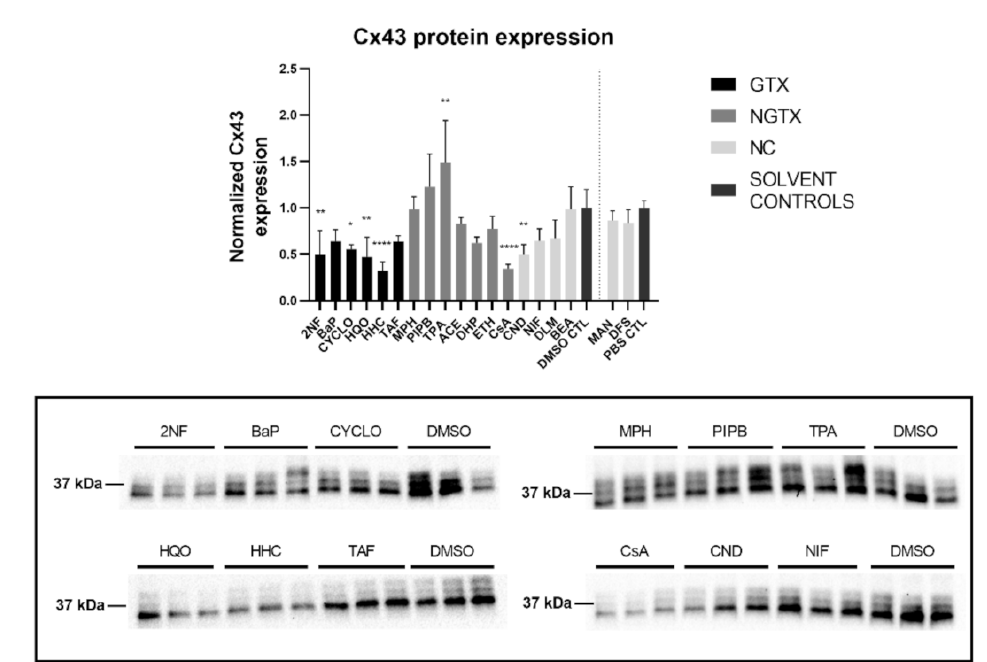
Figure 7. Cx43 protein expression in human hepatoma HepaRG cells exposed to GTX, NGTX and NC chemicals. Human hepatoma HepaRG cells ( n = 3 and N = 1) were exposed to GTX, NGTX, and NC chemicals for 72 h. Densiometric quantitative data were obtained via Image Lab 6.0.1 software (Bio-Rad, Hercules, CA, USA). Data were normalized to the total protein loading (Figure S9) according to Bio-Rad’s instructions [40] and expressed as a ratio to their respective solvent control (DMSO CTL or PBS CTL). Significant difference compared to the solvent control was calculated with a parametric one-way ANOVA followed by a Dunnett’s post-hoc test to correct for multiple comparisons. Data are expressed as mean ± standard deviation with * p ≤ 0.05 ** p ≤ 0.01 and **** p ≤ 0.0001. Only blots containing significantly affected expression patterns are shown.